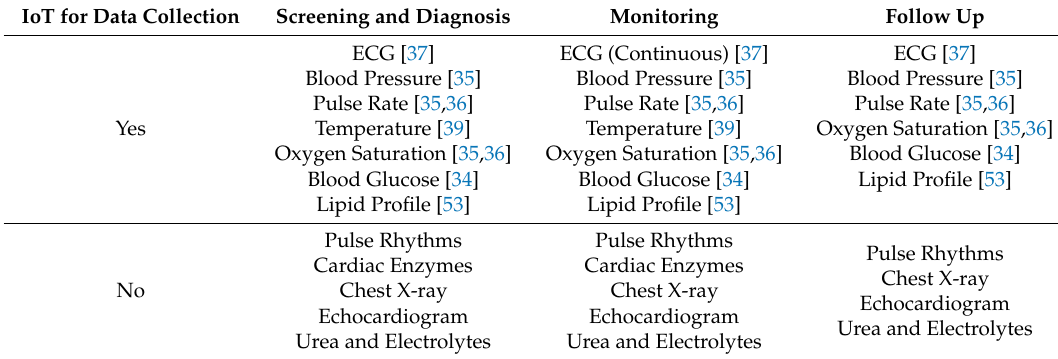
Table 3. Required data and IoT availability of coronary heart